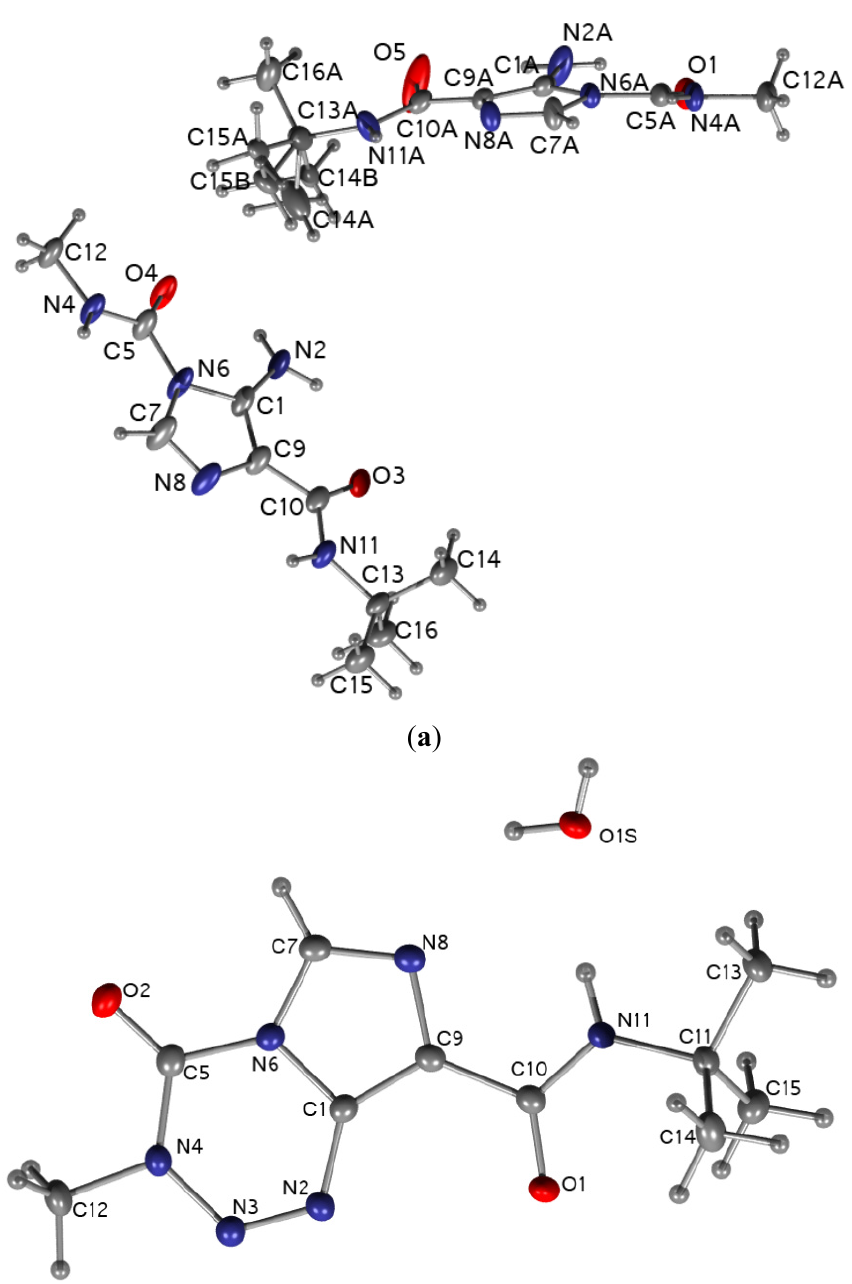
Figure 4. Molecular structure and atomic labelling of TZ-5 ( a ) and TZ-6 ( b ). Thermal displacement ellipsoids are drawn at the 50% probability